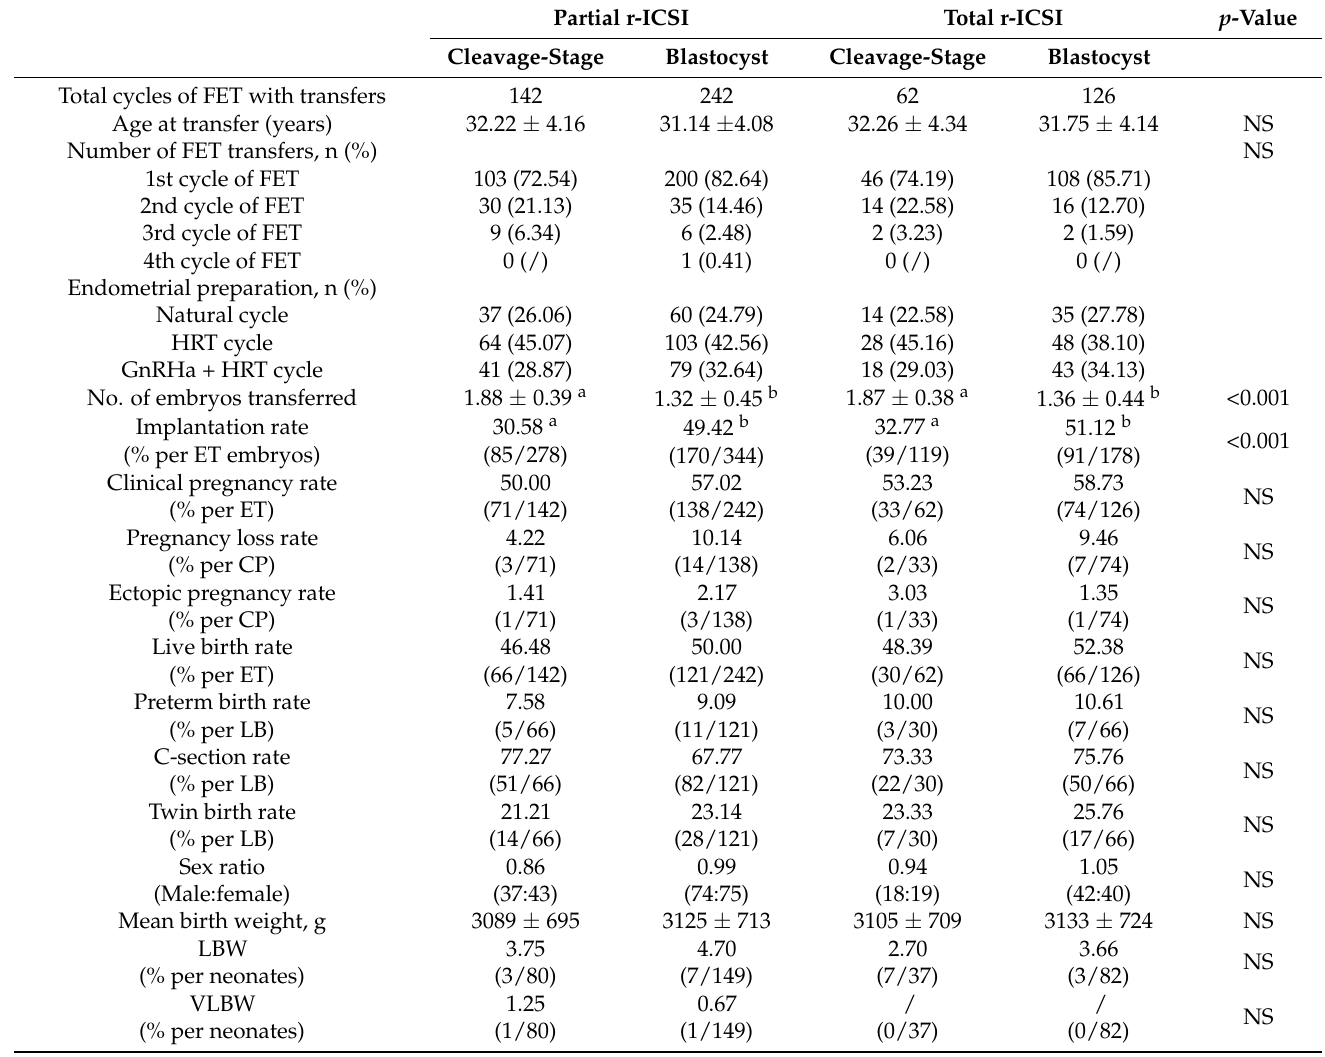
Table 5. Pregnancy, delivery, and neonatal outcomes from r-ICSI derived frozen-thawed ET cycles. Partial r-ICSI Total r-ICSI p -Value Cleavage-Stage Blastocyst Cleavage-Stage Blastocyst